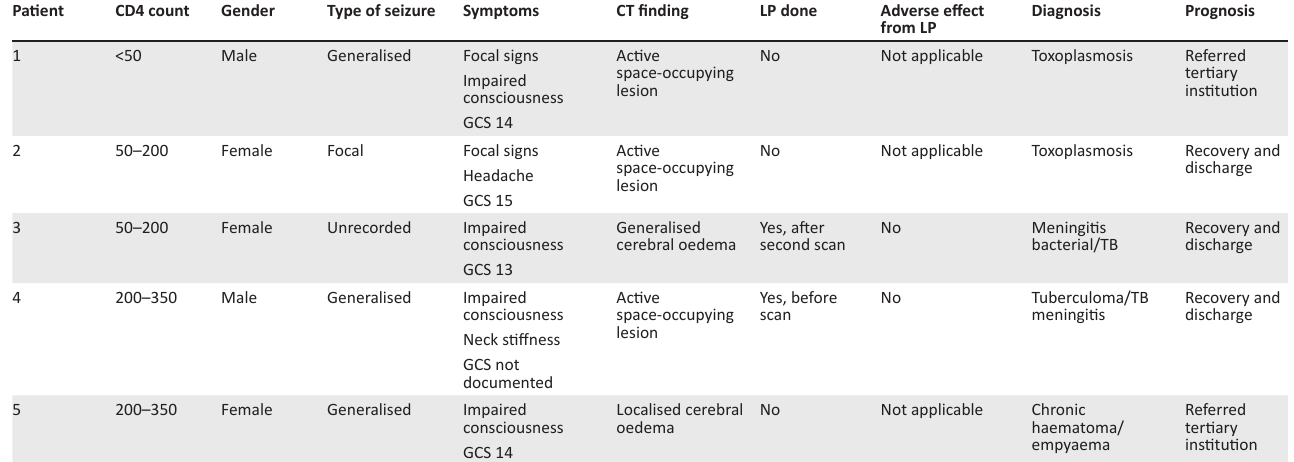
TABLE 2: Description of patients with brain